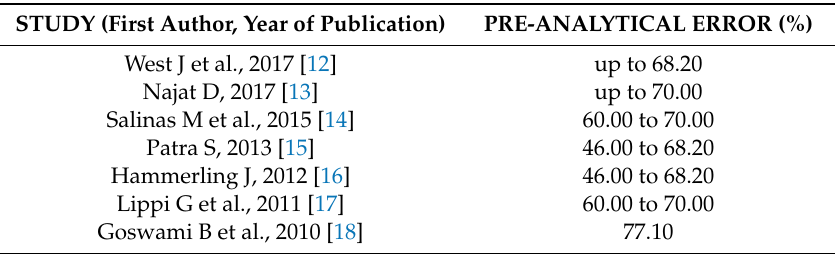
Table 1. Statistical report on pre-analytical errors (2010–2017).